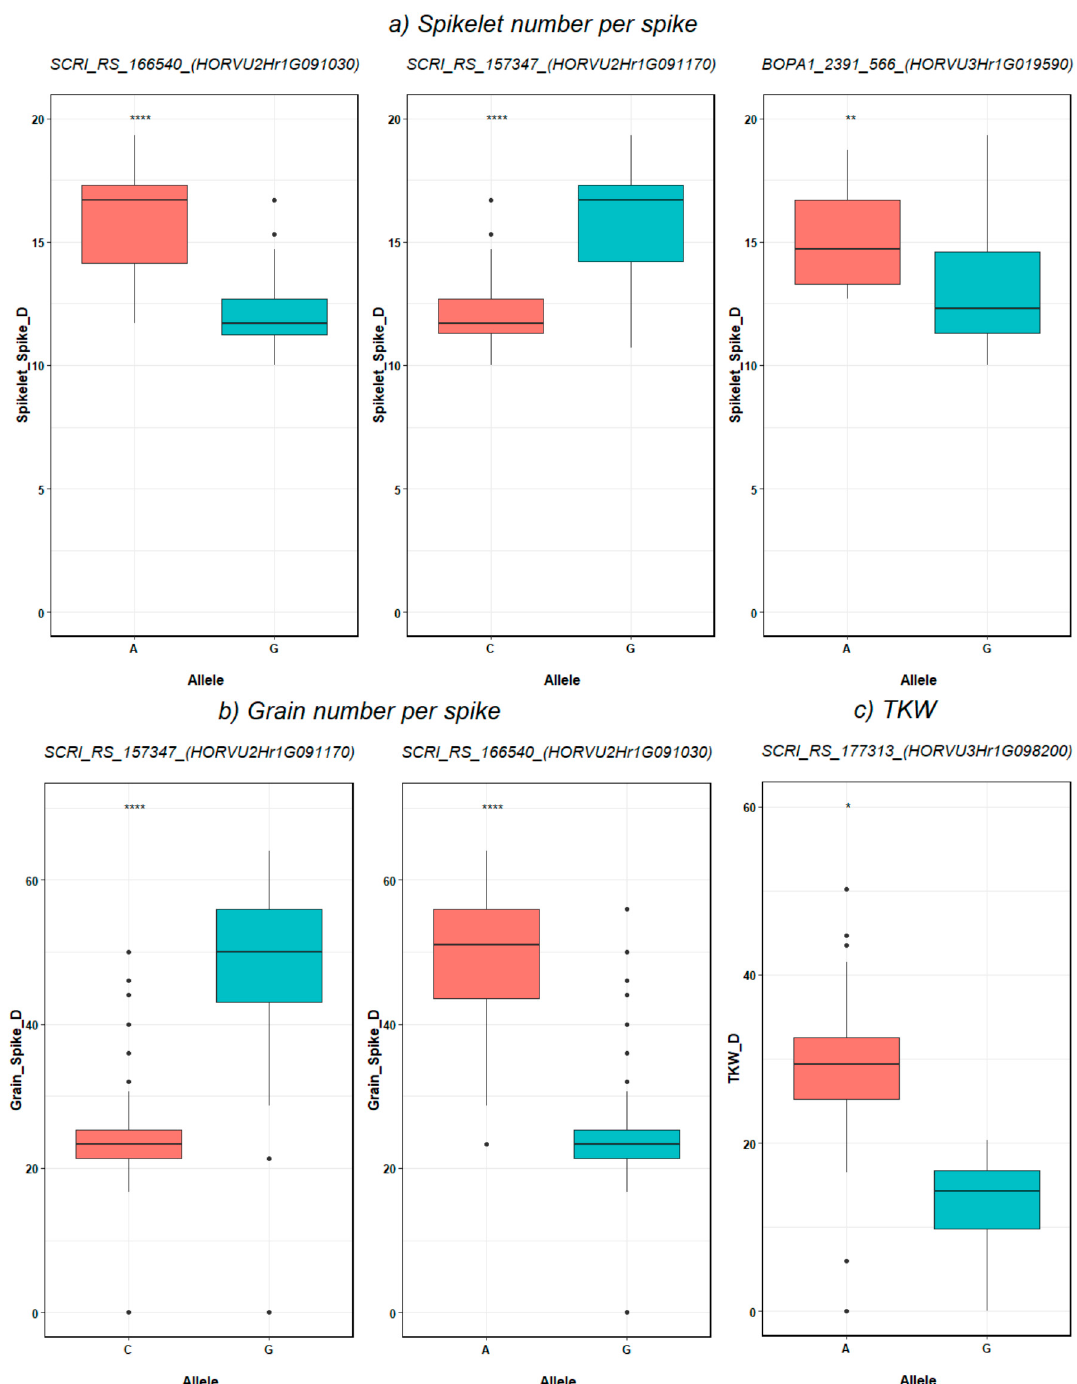
Figure 5. SNP-gene-based analysis for ( a ) Spikelet number per spike, ( b ) Grain number per spike in barley genotype, and ( c ) TKW (gram). The degree of significance indicated as * p , 0.05; ** p , 0.01; *** p , 0.001; **** p , 0.0001.